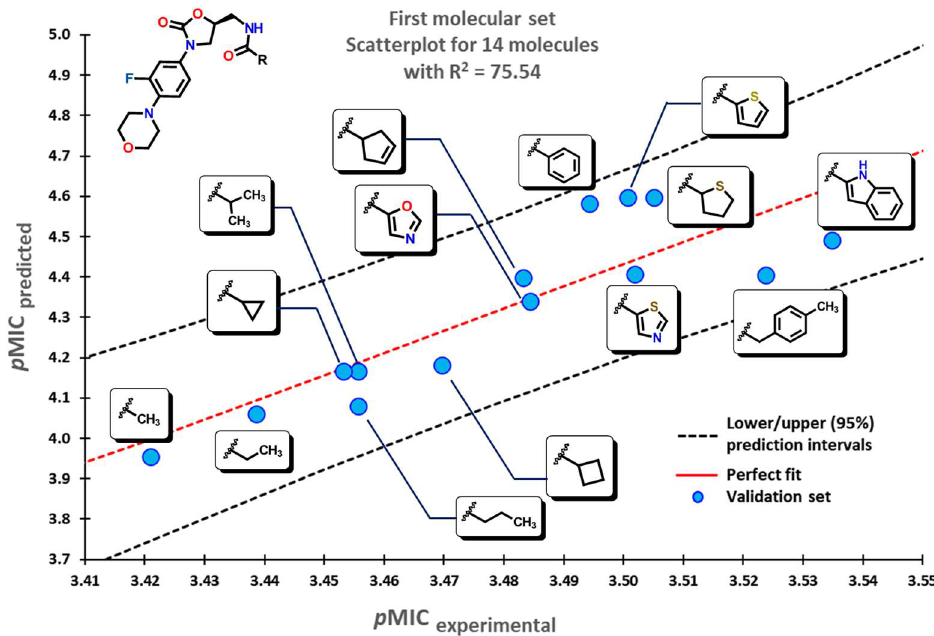
Figure 4. Scatterplot for molecular data set of linezolid analogs. Selected molecules are displayed within the plot showing the change of substituent.